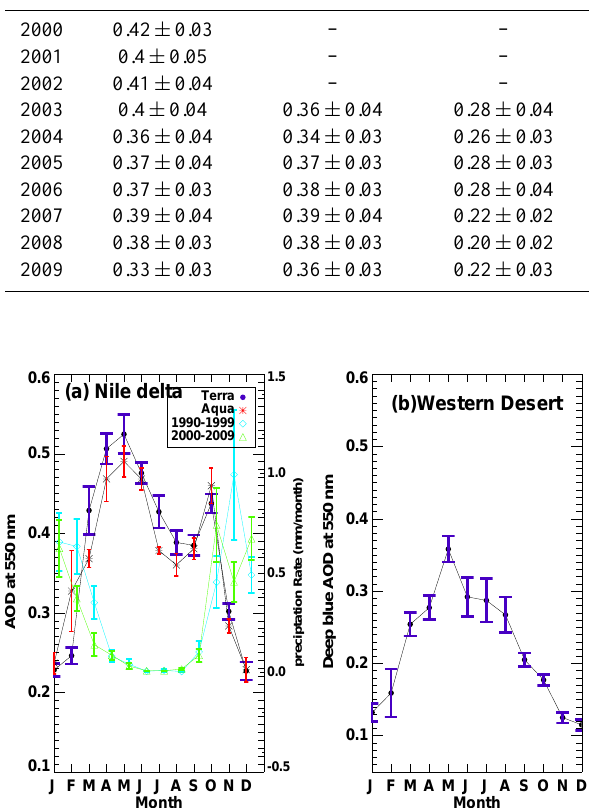
Fig. 3. (a) Climatology MODIS monthly AOD means over the Nile Delta from Terra (2000–2009) and Aqua (2003–2009), the right axis is for the precipitation rate of Nile Delta for 1990–1999 and 2000–2009. (b) Climatology MODIS monthly AOD means over the Western desert using Aqua deep blue (2003–2009) data prod- uct, the vertical bars represent the standard